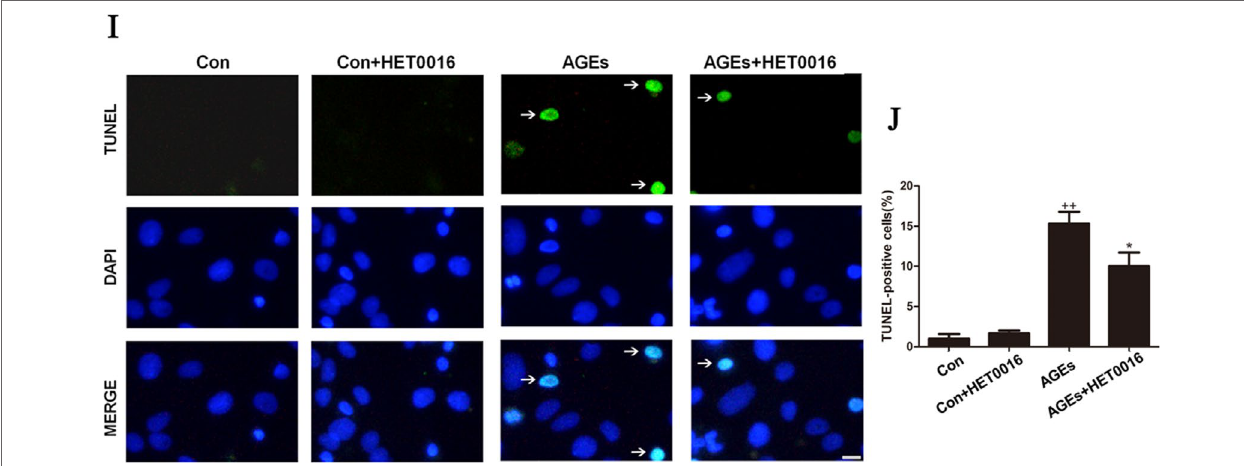
FIGURE 2 | Inhibition of CYP4A with HET0016 reduces myocardial apoptosis induced by AGEs in mice and cardiomyocytes. (A) Hematoxylin and eosin (HE) staining and TUNEL staining of mouse heart tissues. Scale bar = 50 μ m. (B) Relative apoptosis rates are represented as TUNEL-positive cells/DAPI-positive cells, n = 6. (C–G) Protein expression of p-Akt, p-JNK, Bcl-xL, and c-caspase-3. n = 3. (H) Cell viability of rat cardiomyocytes detected with cell counting kit 8. n = 6. (I) Apoptosis of rat cardiomyocytes via TUNEL staining. (J) Relative apoptosis rates are represented as TUNEL-positive cells/DAPI-positive cells, n = 3. Cardiomyocytes were isolated and cultured from ventricles of neonatal rats. Scale bar = 10 μ m. AGEs solution was administered intragastrically to C57BL/6 mice for 60 days, while the specific inhibitor of CYP4A, HET0016, was given from the 47th day via intraperitoneal injection. Con, control. Compared with the Con group, +p < 0.05, ++p < 0.01, +++p < 0.001; compared with the AGEs group, *p < 0.05, **p < 0.01 (one-way ANOVA with Tukey post hoc